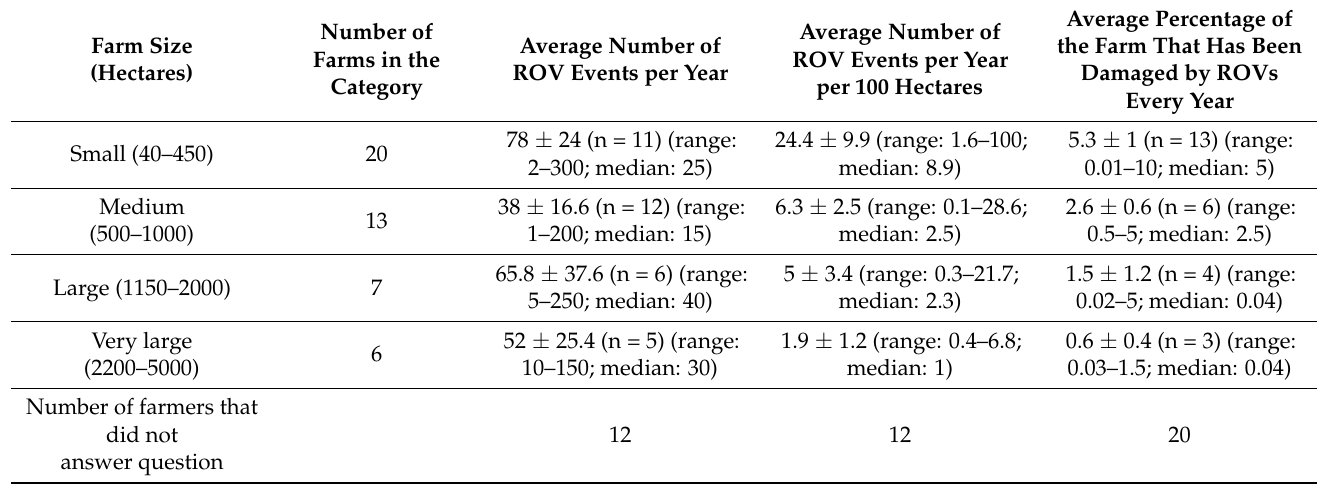
Figure 1. A map of northern and central Israel, with geographical locations (blue marks) of 119 reports on ROV activity events within agricultural fields, provided by the 46 farmers that participated in this study. Green areas represent agricultural fields of vegetables, field crops, and plantations. Table 2. Sizes of the farms included in the study and ROV events that took place in the past five years. n = number of farmers in the category that answered the question.